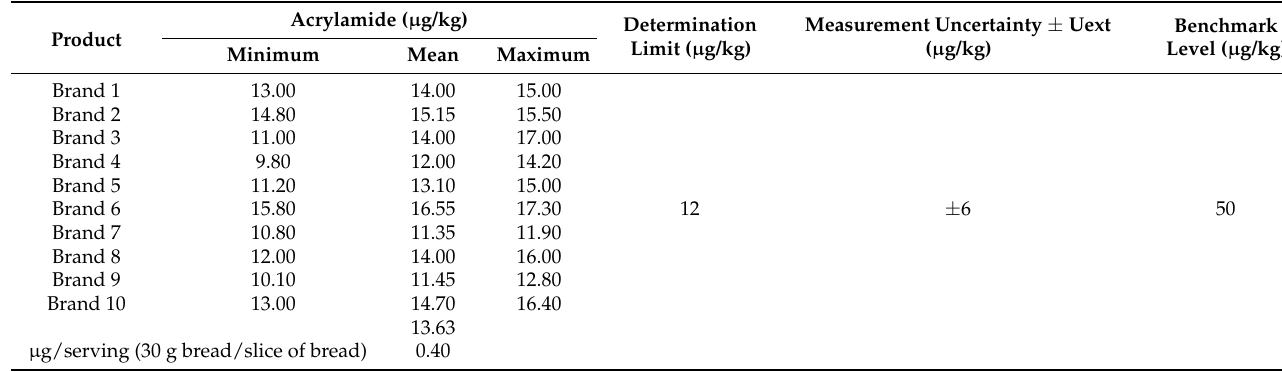
Table 3. The acrylamide level in white bread ( µ g/kg).